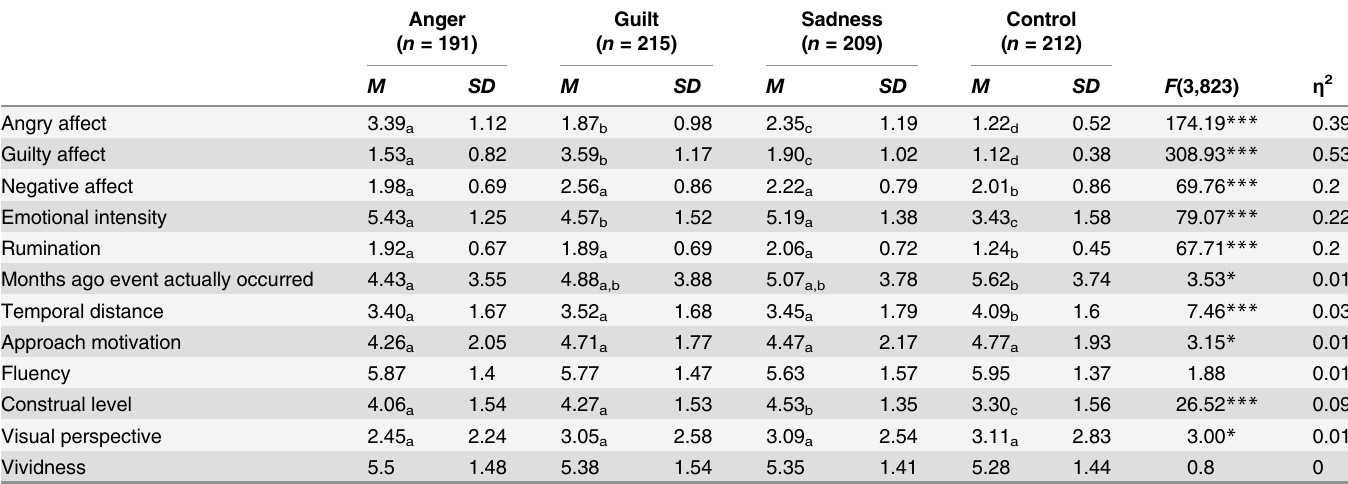
Table 4. Means and (standard deviations) of the measures from Study 3.